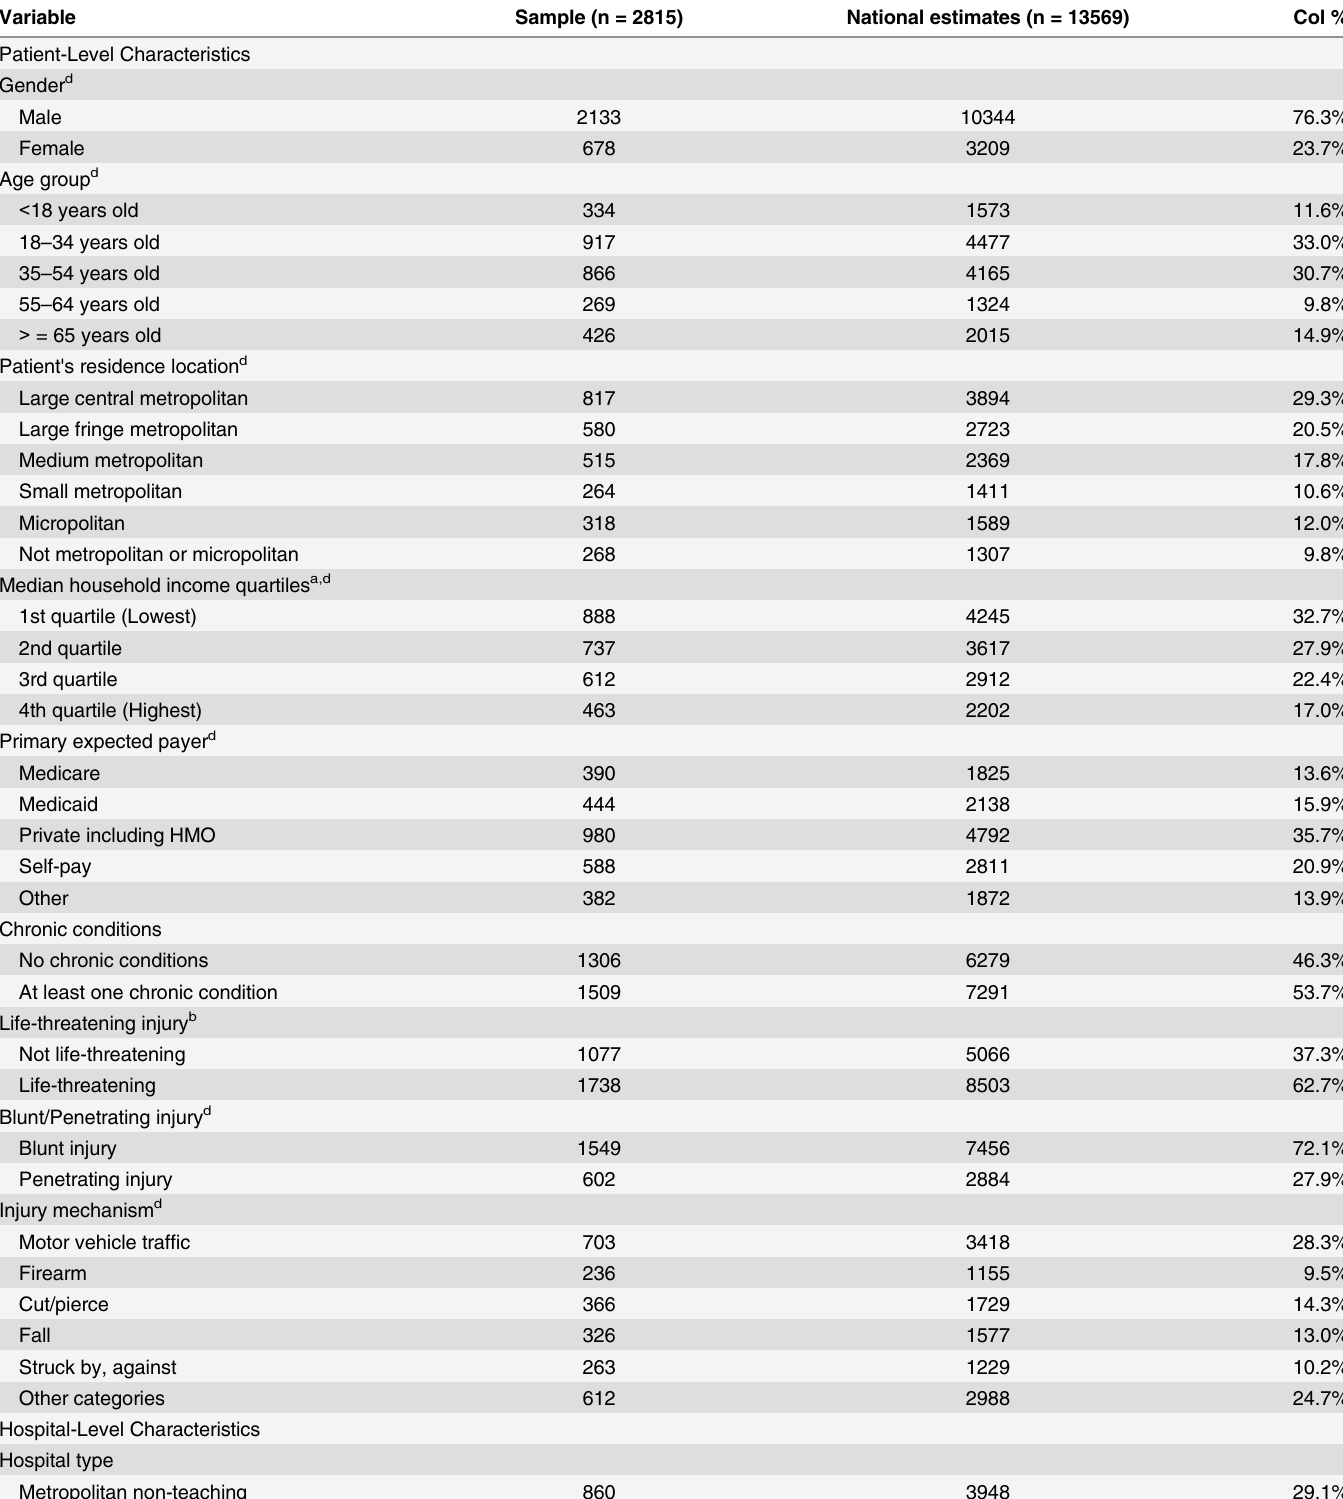
Table 1. Patient and hospital characteristics of trauma patients with ISS 75, NEDS 2006 –